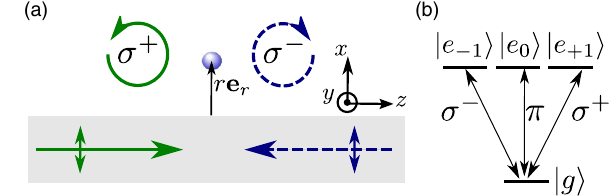
FIG. 1. Chiral photons in evanescent fields coupled to spin- polarized atoms. (a) Polarization properties of the evanescent light field that surrounds an optical nanofiber (gray). A light field that propagates in the ðþ z Þ direction and whose main polarization axis (double arrow) is along the x axis is almost fully σ þ polarized (green solid arrows) in the ( y ¼ 0 ) plane. If it propagates in the ð − z Þ direction, it is almost fully σ − polarized (blue dashed arrows). The quantization axis is chosen along y , i.e., orthogonal to the propagation direction. An atom (light blue sphere) placed at a distance r to the nanofiber surface couples to the evanescent field. (b) Relevant energy levels of the atom. The ground state j g i is coupled to the excited states j e − 1 i , j e 0 i , and j e i via σ − , π , þ 1 and σ þ transitions,